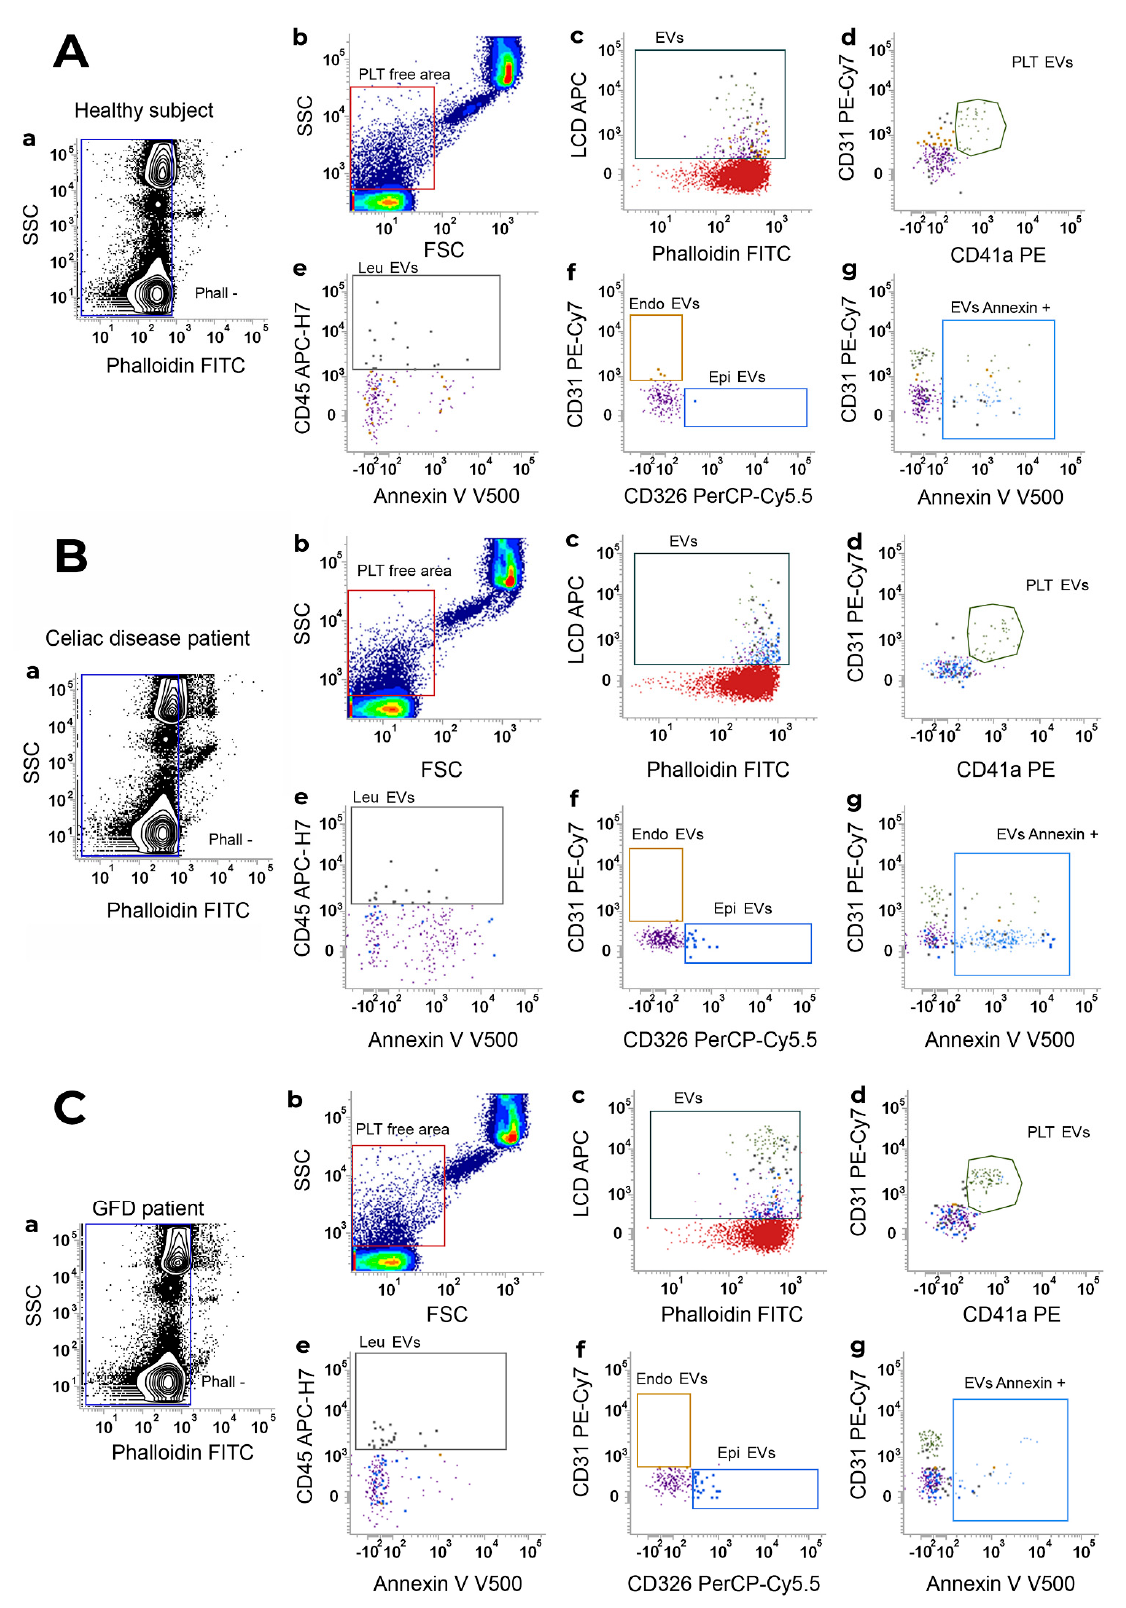
Figure 1. Gating strategy for EV identification. EV identification and sub-typing in ( A ) healthy subjects, ( B ) Celiac disease patients and ( C ) celiac disease patients under a gluten-free diet (GFD patient). ( a ) Phalloidin-negative events were firstly gated and ( b ) analyzed for their